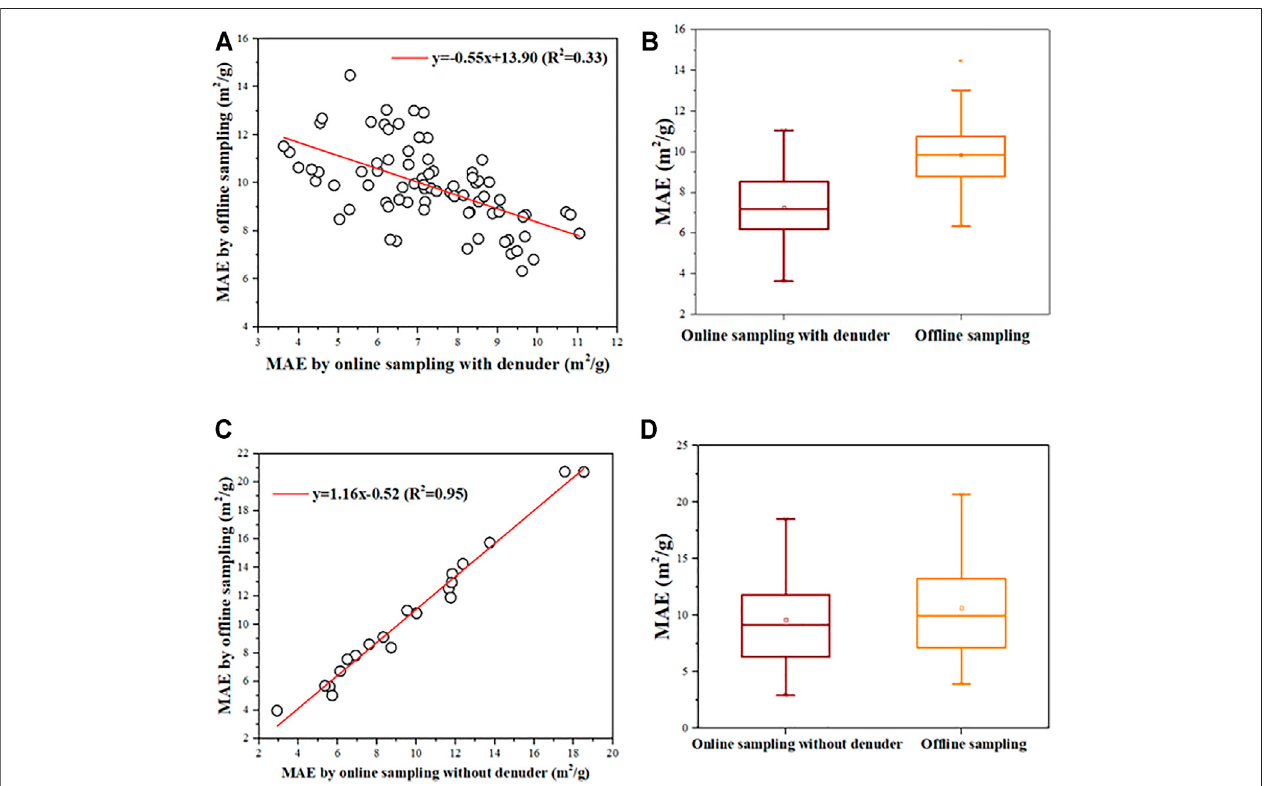
FIGURE1| Comparisonofmassabsorptionef fi ciency(MAE)valuesbetweenof fl ineandonlinesamplings. (A) ThecorrelationbetweenMAEbyof fl inesamplingand that by online sampling with adenuder. (B) Box plots of MAEby of fl ine sampling and that by online sampling with a denuder. (C) The correlation between MAE byof fl ine sampling and that by online sampling without a denuder. (D) Box plots of MAE by of fl ine sampling and that by online sampling without a denuder.